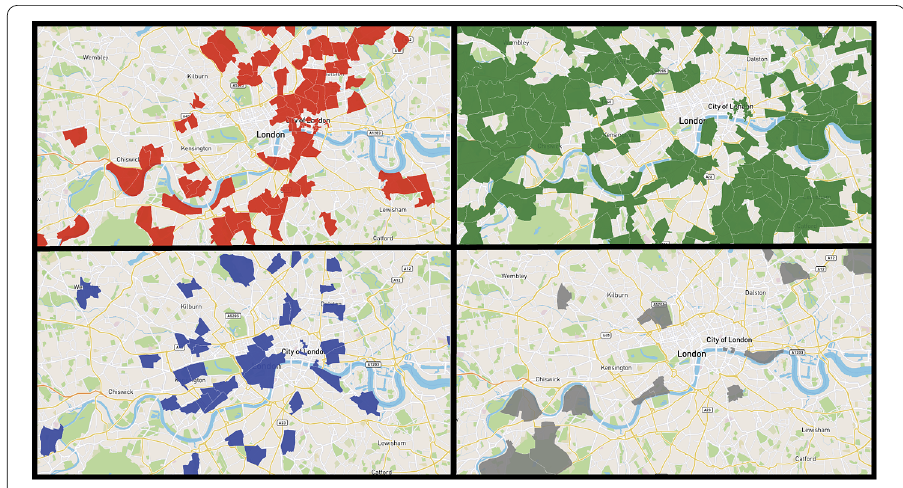
Figure 1 Venue category popularity. The most popular category in each ward at 17:00. NightlifeSpots are represented in red, Travel&Transport in green, Food in blue, and Outdoors&Recreation in